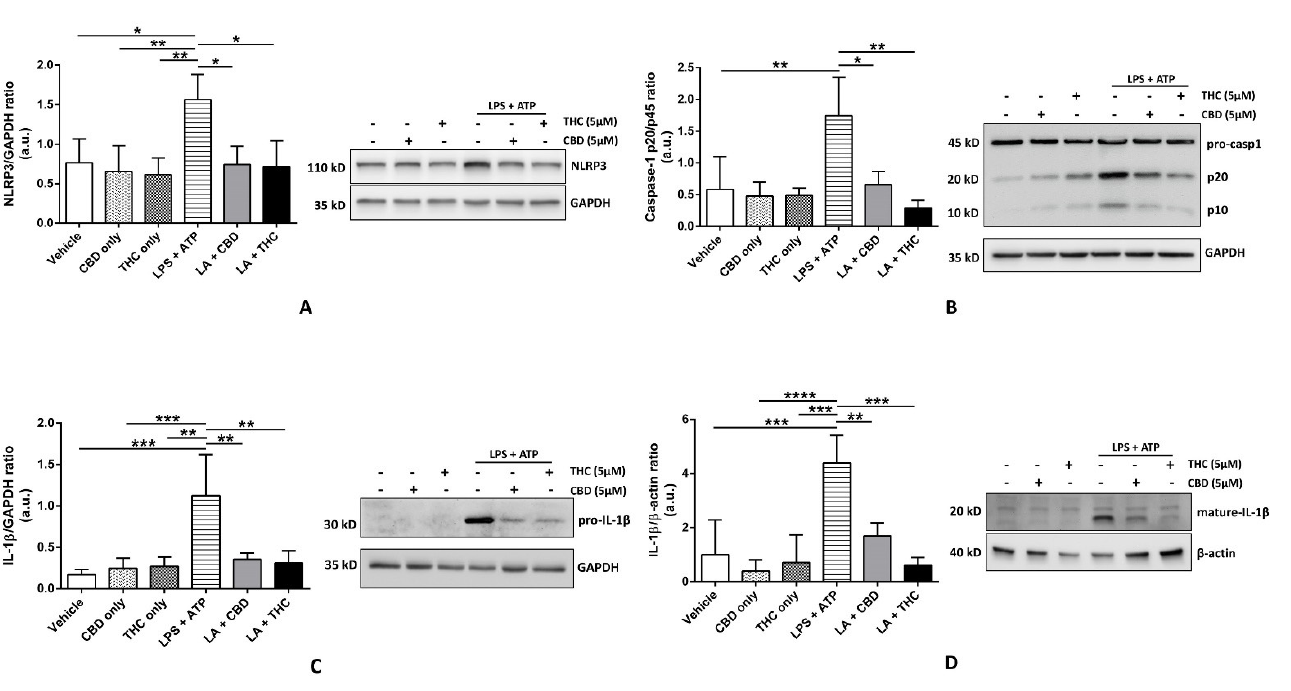
Figure 1. Effect of cannabinoids on the expression of NLRP3 inflammasome proteins in THP-1 macrophages. ( A ): CBD and THC decreased the expression of NLRP3 after LPS + ATP stimulation in THP-1 macrophages: Representative Western blots of NLRP3 and GAPDH bands and the quantification of the same using one-way ANOVA with Tukey’s multiple-comparison test. Four independent experiments ( n = 3–4) of THP-1 cell lysates obtained after pre-treatment with CBD or THC for 30 min and LPS stimulation for 3 h followed by ATP for 1 h were analyzed, and data are expressed as means ± SD; * p < 0.05, ** p < 0.01. (Abbreviation: LA: LPS + ATP). ( B ): CBD and THC decreased the ratio of the expressions of caspase-1 p20/p45 after LPS + ATP stimulation in THP-1 macrophages: Representative Western blots of caspase-1 p45 (pro-caspase1), p20, and GAPDH bands and the quantification of caspase-1 p20/p45 ratio using one-way ANOVA with Tukey’s multiple-comparison test. Four independent experiments ( n = 4) of THP-1 cell lysates obtained after pre-treatment with CBD or THC for 30 min and LPS stimulation for 3 h followed by ATP for 1 h were analyzed, and data are expressed as means ± SD; * p < 0.05, ** p < 0.01. (Abbreviation: LA: LPS + ATP). ( C ): CBD and THC decreased the expression of pro-IL-1 β after LPS + ATP stimulation in THP-1 macrophages: Representative Western blots of pro-IL-1 β and GAPDH bands and the quantification of the same using one-way ANOVA with Tukey’s multiple-comparison test. Four independent experiments ( n = 4) of THP-1 cell lysates obtained after pre-treatment with CBD or THC for 30 min and LPS stimulation for 3 h followed by ATP for 1 h were analyzed, and data are expressed as means ± SD; ** p < 0.01, *** p < 0.001. (Abbreviation: LA: LPS + ATP). ( D ): CBD and THC decreased the expression of mature IL-1 β after LPS + ATP stimulation in cell supernatants of THP-1 macrophages: Representative Western blots of mature-IL-1 β and β -actin bands and the quantification of the same using one-way ANOVA with Tukey’s multiple-comparison test. Four independent experiments ( n = 4) of THP-1 cell supernatants obtained after pre-treatment with CBD or THC for 30 min and LPS stimulation for 3 h followed by ATP for 1 h were analyzed, and data are expressed as means ± SD; ** p < 0.01, *** p < 0.001, **** p < 0.0001. (Abbreviation: LA: LPS + ATP).